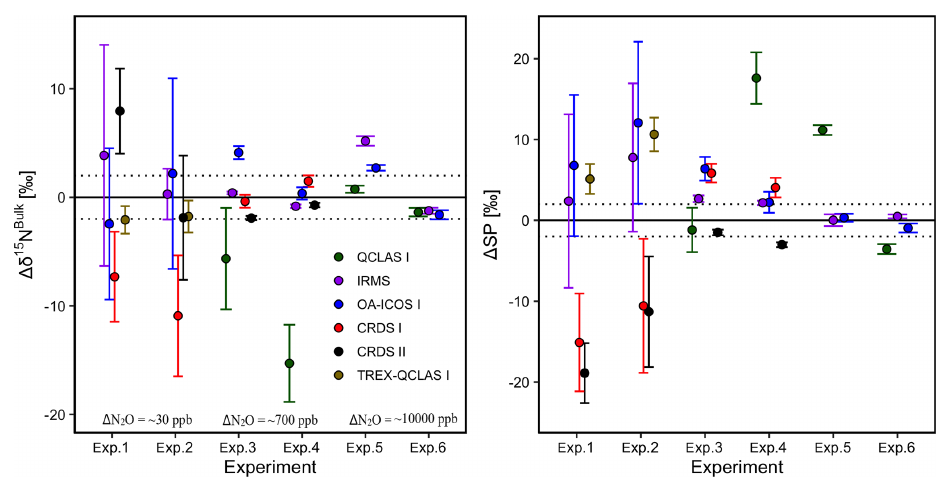
Figure 14. (cid:49)δ 15 N bulk and (cid:49) SP ( Estimated Source − True Source ) values derived from the OA-ICOS I (blue), CRDS I (red), CRDS II (black), QCLAS I (green) and IRMS (purple) via Keeling analysis of the two-end-member mixing scenario. The remaining plots for δ 15 N α , δ 15 N β and δ 18 O are provided in Sect. S4 (Fig. S4-15). Estimated Source = True Source is indicated by a solid black line at y = 0, and the dotted lines indicated ± 2‰ deviation from y = 0. The change in concentration exceeding that of the background gas is indicated for Exps. 1–2 ( (cid:49) N 2 O =∼ 30ppb), 3–4 ( (cid:49) N 2 O =∼ 700ppb) and 5–6 ( (cid:49) N 2 O =∼ 10000ppb). Note that the QCLAS I results for Exps. 1 and 2 are not depicted to maintain clarity, as they exceed the selected y -axis scale. Table 8. Summary of main findings presented in this